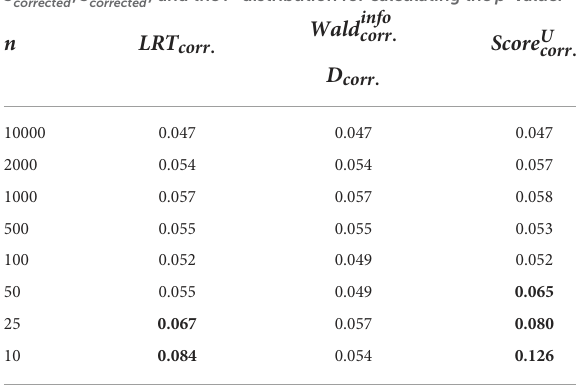
TABLE 5 Type I error rates when using R 1 , ˆ S 2 corrected (or ˜ S 2 ¯ S 2 ¯ F -distribution for calculating the p -value. corrected , corrected ) and the